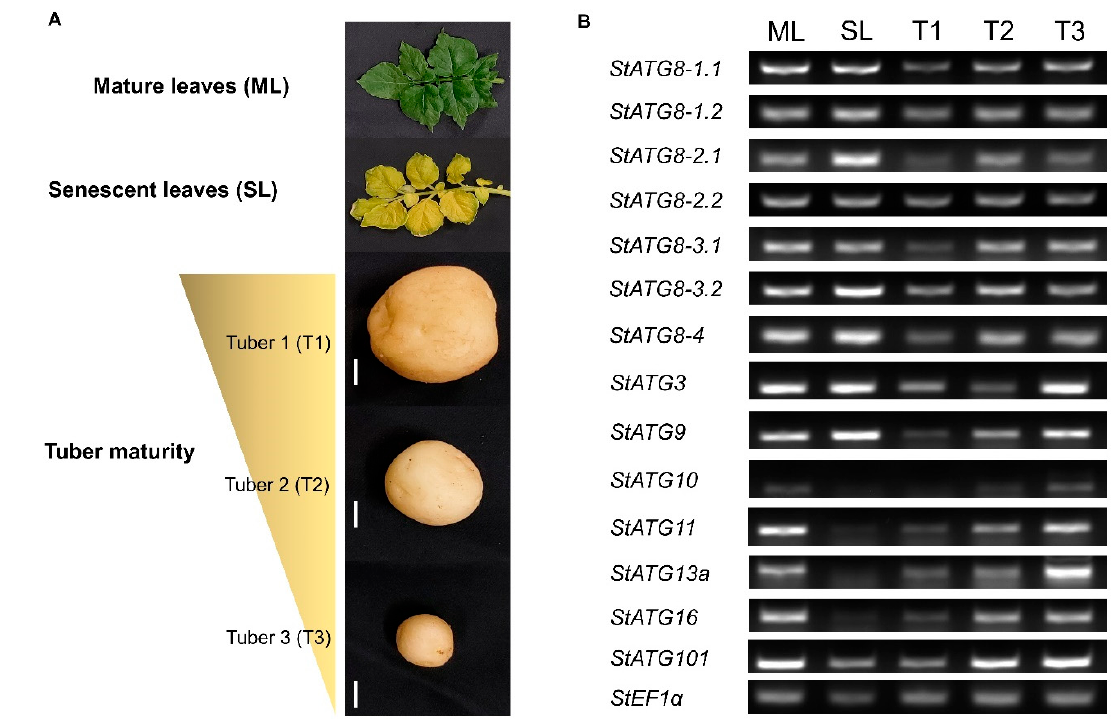
Figure 3. Expression patterns of StATGs in mature leaves, senescent leaves, and tubers. ( A ). Pho- tographs of fully mature leaves, senescent leaves, and tubers of potato plants were used for sampling. ( B) . Semiquantitative RT-PCR measurement of StATGs expression in mature leaves (ML), senescent leaves (SL), and tubers (T1 to T3). StEF1 α was used as a reference gene. The white bar represents 1 cm. Semi-quantitative RT-PCR was performed using the StATG gene-specific primers and primer information is in Supporting Table S2.